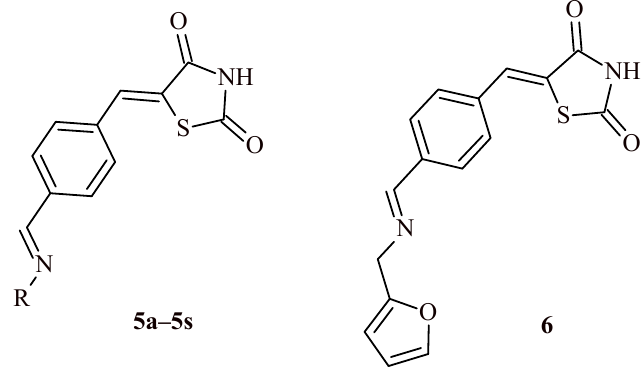
Figure 2. The 5-Arylidenethiazolidine-2,4-dione derivatives ( 5a – 5s ) and 6 with antioxidant and antimicrobial activity.